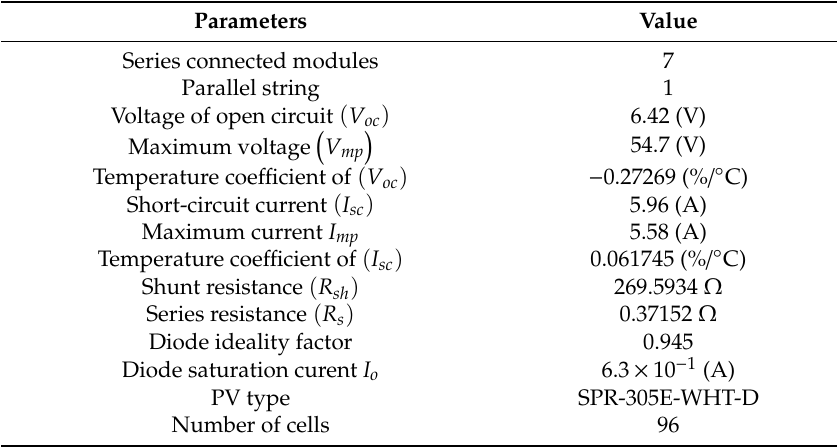
Table 1. Electrical parameters of the SPR—305 E—WHT—D